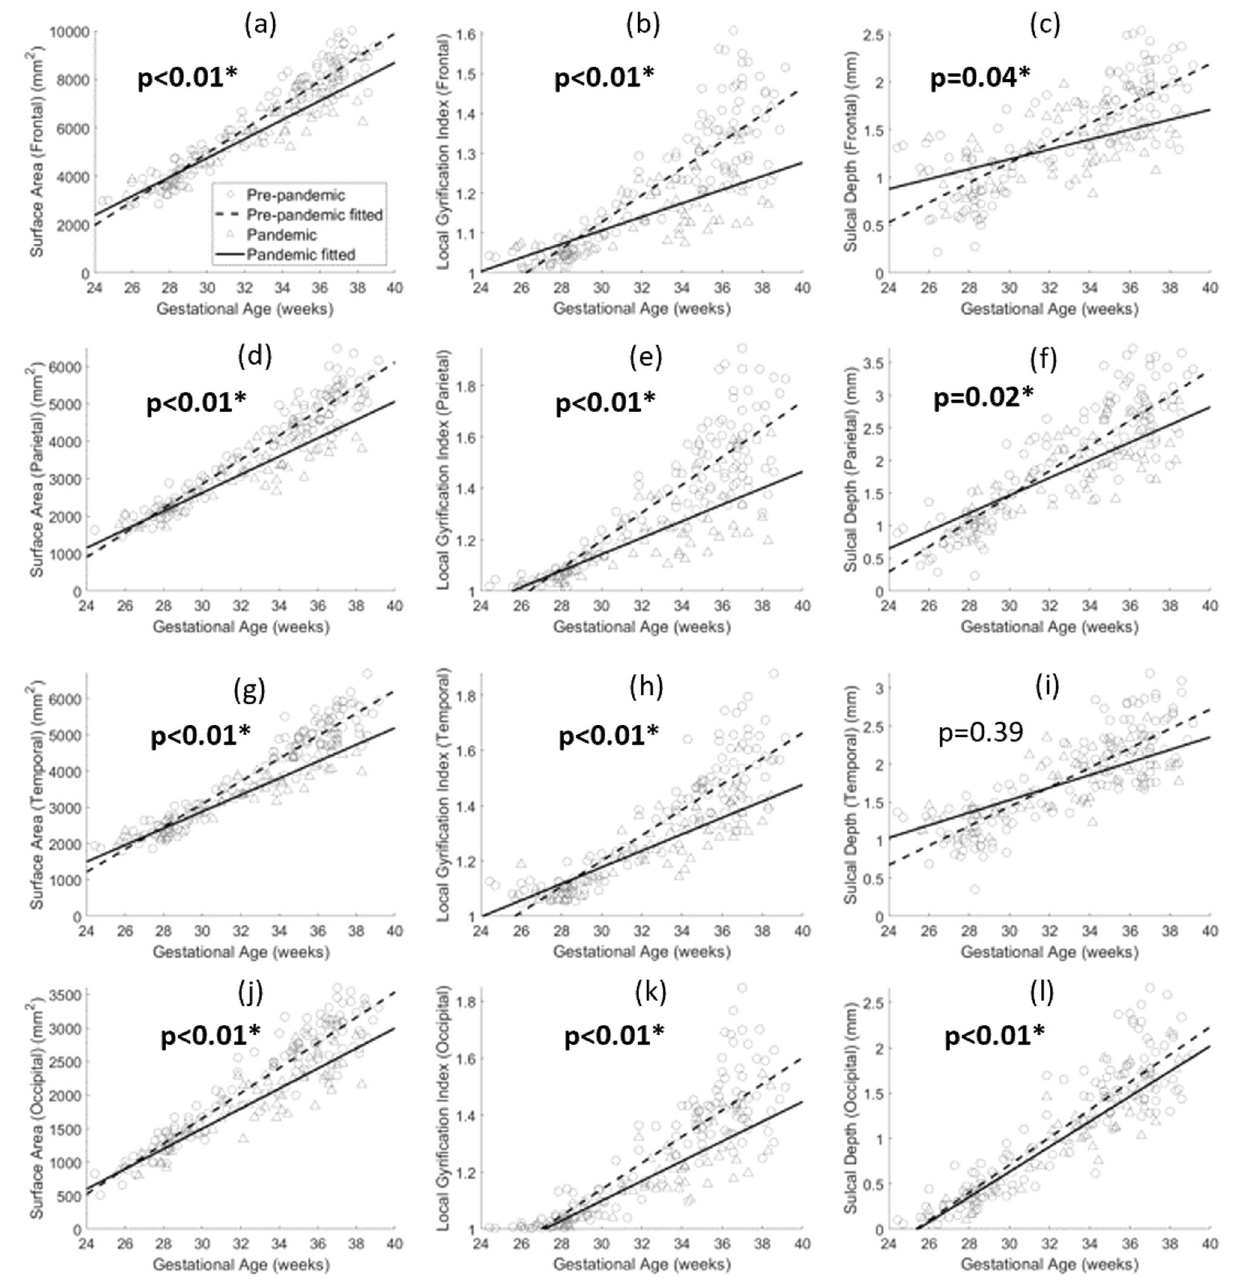
Fig. 2 Scatter plots with linear fi ts of brain lobe surface area/LGI/sulcal depth vs. gestational age. a – c : Frontal lobe; d – f Parietal lobe; g – i : Temporal lobe; j – l : Occipital lobe. The p -values are the main effects of pandemic vs. pre-pandemic on brain cortical features while controlling for gestational age at MRI and fetal sex. Bold p : p < 0.05. *: q < 0.05. Sample size N =